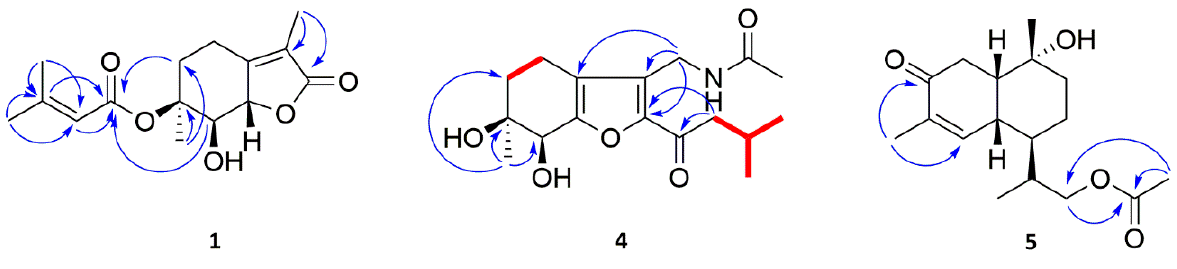
Figure 2. 1 H- 1 H COSY ( Figure 2. 1 H- 1 H COSY ( ) and HMBC ( ) correlations of compounds 1 , 4 and 5 . ) and HMBC ( Figure 2. 1 H- 1 H COSY ( ) and HMBC ( ) correlations of compounds 1 , 4 and 5 . ) correlations of compounds 1 , 4 and 5 Figure 2. 1 H- 1 H COSY ( ) and HMBC ( ) correlations of compounds 1 , 4 and 5 .